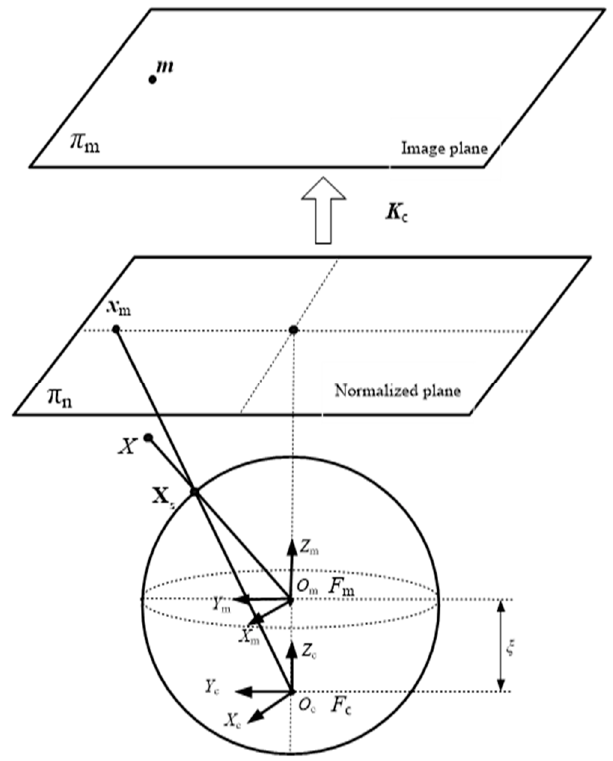
Figure 3. The unit sphere model for the catadioptric camera.